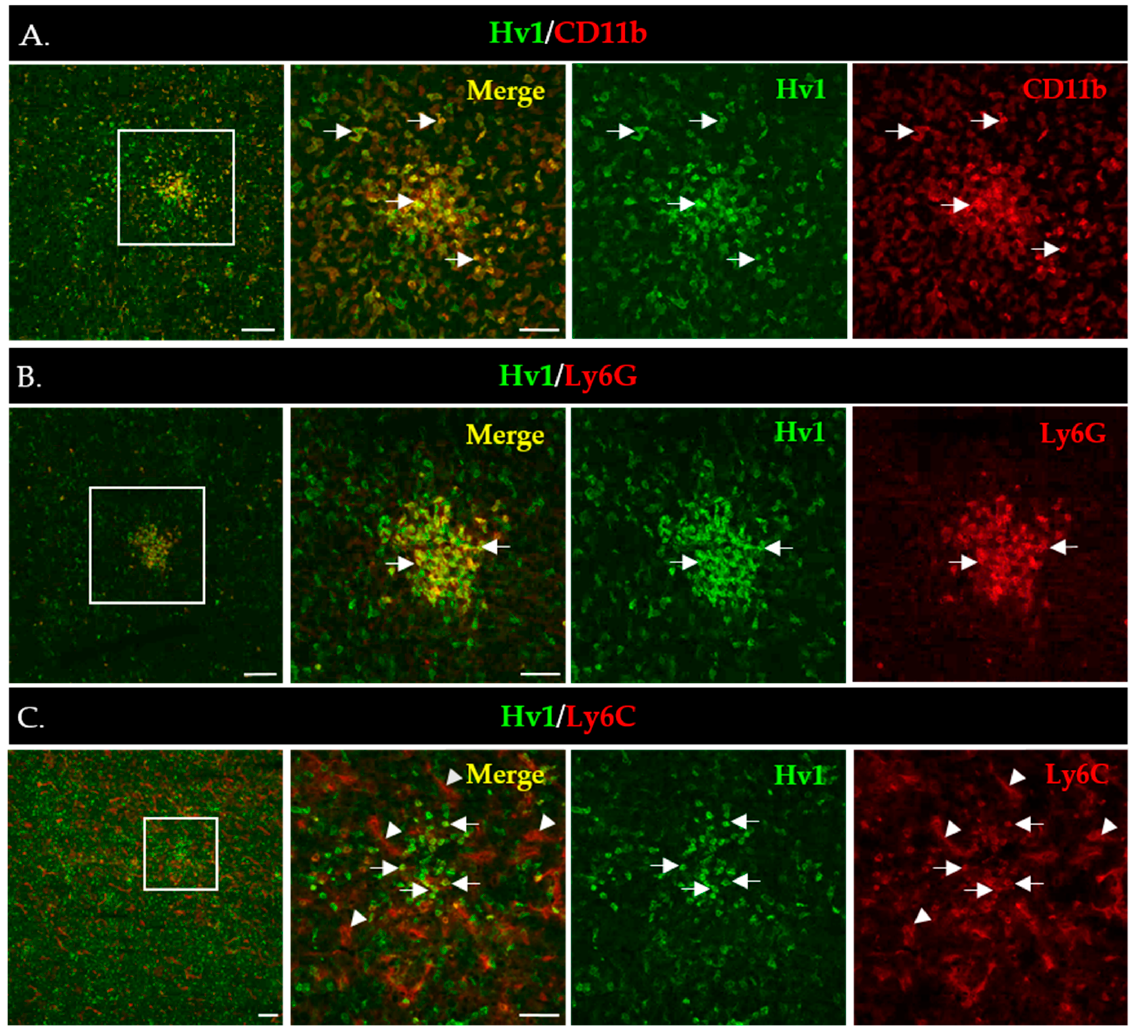
Figure 6. Immunofluorescence staining of LLC cryosections to detect expression of Hv1 by myeloid cells ( A – C ). Boxed areas in the 1st column are shown in higher magnification to the right. Scale bars, 100 µm for the lower and 50 µm for the higher magnification images. ( A ) CD11b (red) marks all myeloid cells accumulated in the LLC tumor (4th column); the Hv1 signal is in green (3rd column), whereas the CD11b/Hv1 co-expressing myeloid cells are in yellow in the merged images (2nd column). ( B ) Hv1 + /Ly6G + MDSCs (arrow) cells in an LLC tumor section. L6yG + (red) marks PMN- MSDCs (4th column); the Hv1 signal is in green (3rd column), whereas the L6G + /Hv1 co-expressing myeloid cells are in yellow in the merged images (2nd column). ( C ) Hv1 + /Ly6C + cells (arrow) in a tumor section. Ly6C + (red) marks Mo-MSDCs (4th column); the Hv1 signal is in green (3rd column), whereas the Ly6C + /Hv1 co-expressing myeloid cells are in yellow in the merged images (2nd column). Ly6C additionally marks the blood vessels (arrowheads).